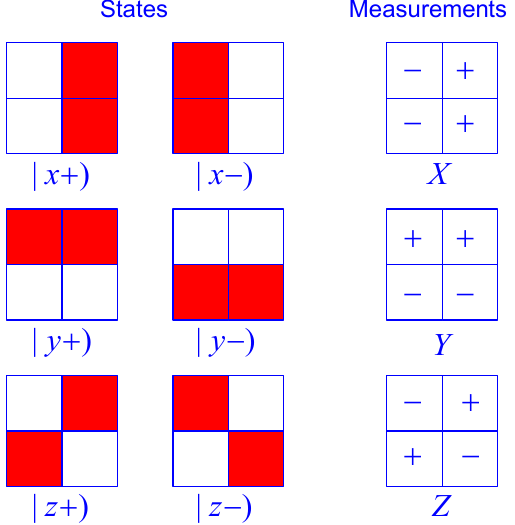
Figure 3: The allowed states and measurements of Spekkens’ toy bit. For the states, a red square indicates that the corre- sponding ontic state has probability 1 / 2 and a white square indicates probability 0 . For the measurements, a square labeled + gives the + 1 outcome with certainty and a square labeled − gives the − 1 outcome with